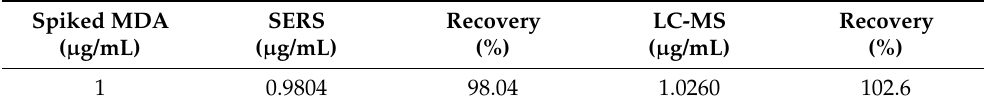
depict the acceptable reliability of the SERS method. Table 1. Recovery and detection of MDA in urine by the sandwich-structure-based SERS strategy and the LC-MS method.